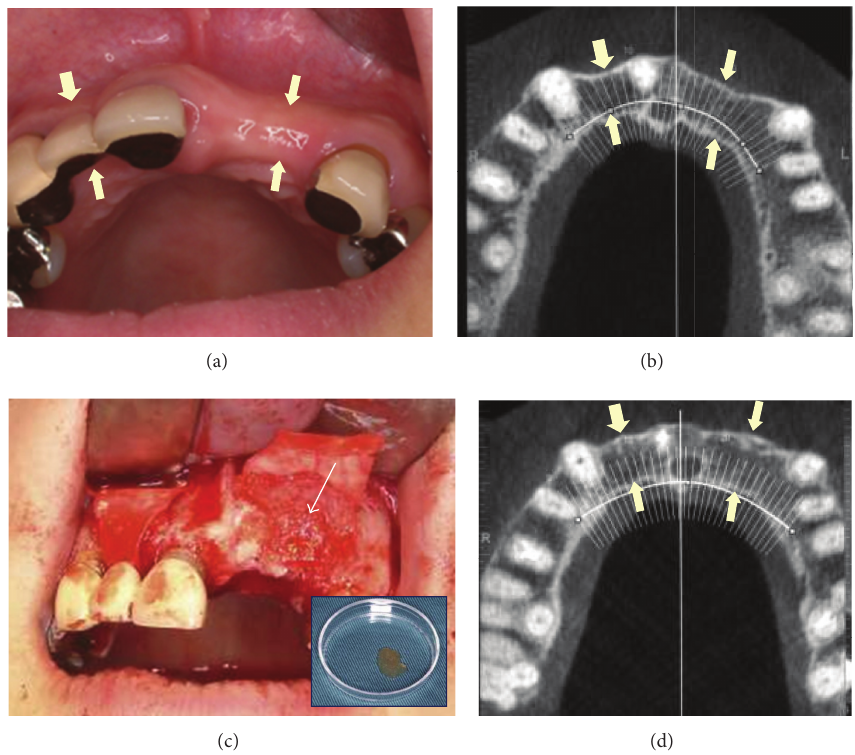
Figure 4: Alveolar ridge augmentation using bFGF-incorporated gelatin sponge and collagen membrane. (a) Preoperative intraoral photograph shows narrow alveolar ridge (arrows); (b) frontal plane of the preoperative dental CT is shown, and (c) bFGF-incorporated gelatin sponge (arrows) is implanted. Inserted photograph demonstrates bFGF-incorporated gelatin sponge, and (d) the narrow alveolar ridge is reconstructed (arrows) 8 months